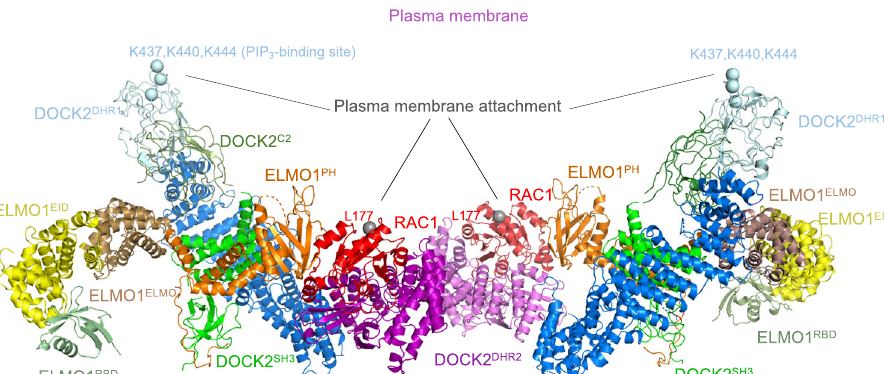
necting ELMO1 NTD and ELMO1 PH . Interactions between the two subunits are centred on stable and invariant contacts between the N-terminal SH3 and helical domains of DOCK2 and the PH domain and poly-Pro segment at the C-terminus of ELMO1. The binary DOCK2 − ELMO1 complex adopts two conformational states. In the closed, auto-inhibited conformation, ELMO1 NTD is positioned to form extensive contacts with ELMO1 PH , DOCK2 C2 and DOCK2 DHR2 (Fig. 3e – right panel). Importantly, the latter interaction involving ELMO1 RBD blocks access of DOCK2 DHR2 for RAC1, thereby suppressing DOCK2 − ELMO1 GEF activity. In the alternative open, active conformation, ELMO1 NTD has swung about the elbow hinge, exposing multiple binding sites on both DOCK2 and ELMO1 (Fig. 9). ELMO1 adopts the same open- conformation in the DOCK2 − ELMO1 − RAC1 ternary complex, indicating that the open-conformation of DOCK2 − ELMO1